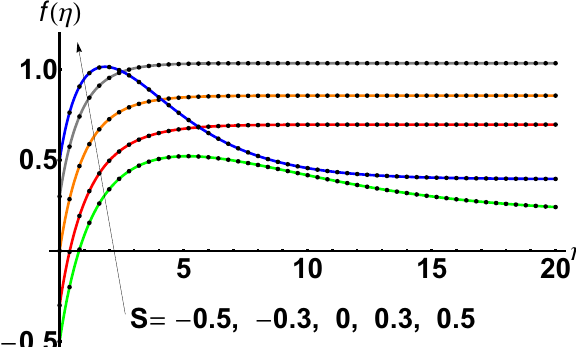
Table 9: Comparison between the mass transfer coefficient ¯ φ ′ (0) obtained by means of the OHAM and numerical results, for S = 0.5 , λ = 0.1 and different values of the Schmidt coefficient Sc (relative